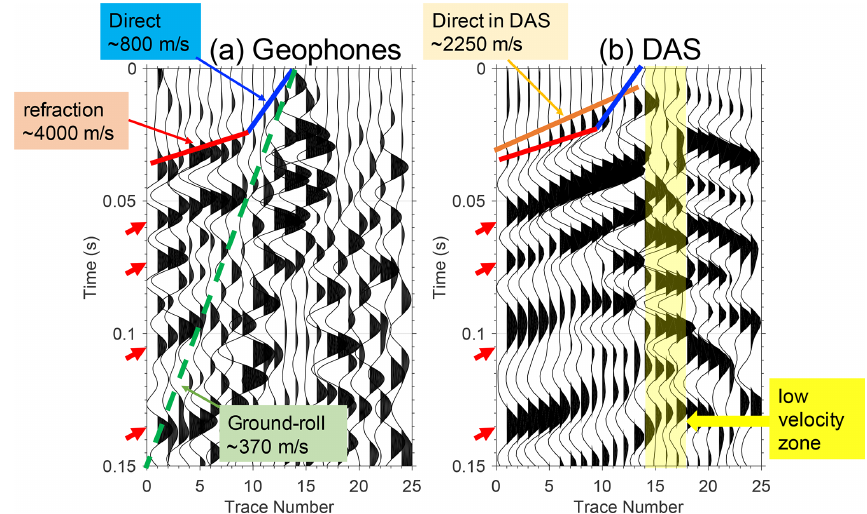
Figure 5. Geophone (a) and DAS (b) active-source shot gather.